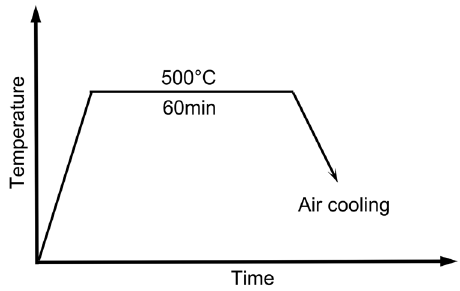
Figure 2: Annealing heat treatment process.